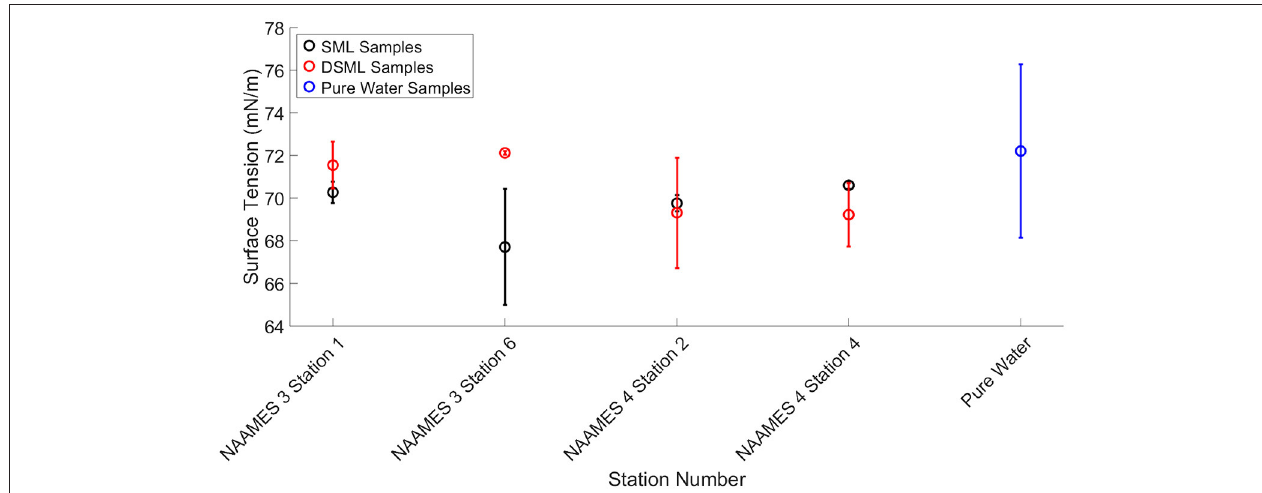
FIGURE 6 | Surface tension measurements of SML samples, DSML samples, and pure water. Black, red, and blue symbols indicate measurements from SML samples, DSML samples, and pure water, respectively. Error bars represent the standard deviation ( n = 21, 16, and 7 for SML samples, DSML samples, and pure water respectively) of the measurements